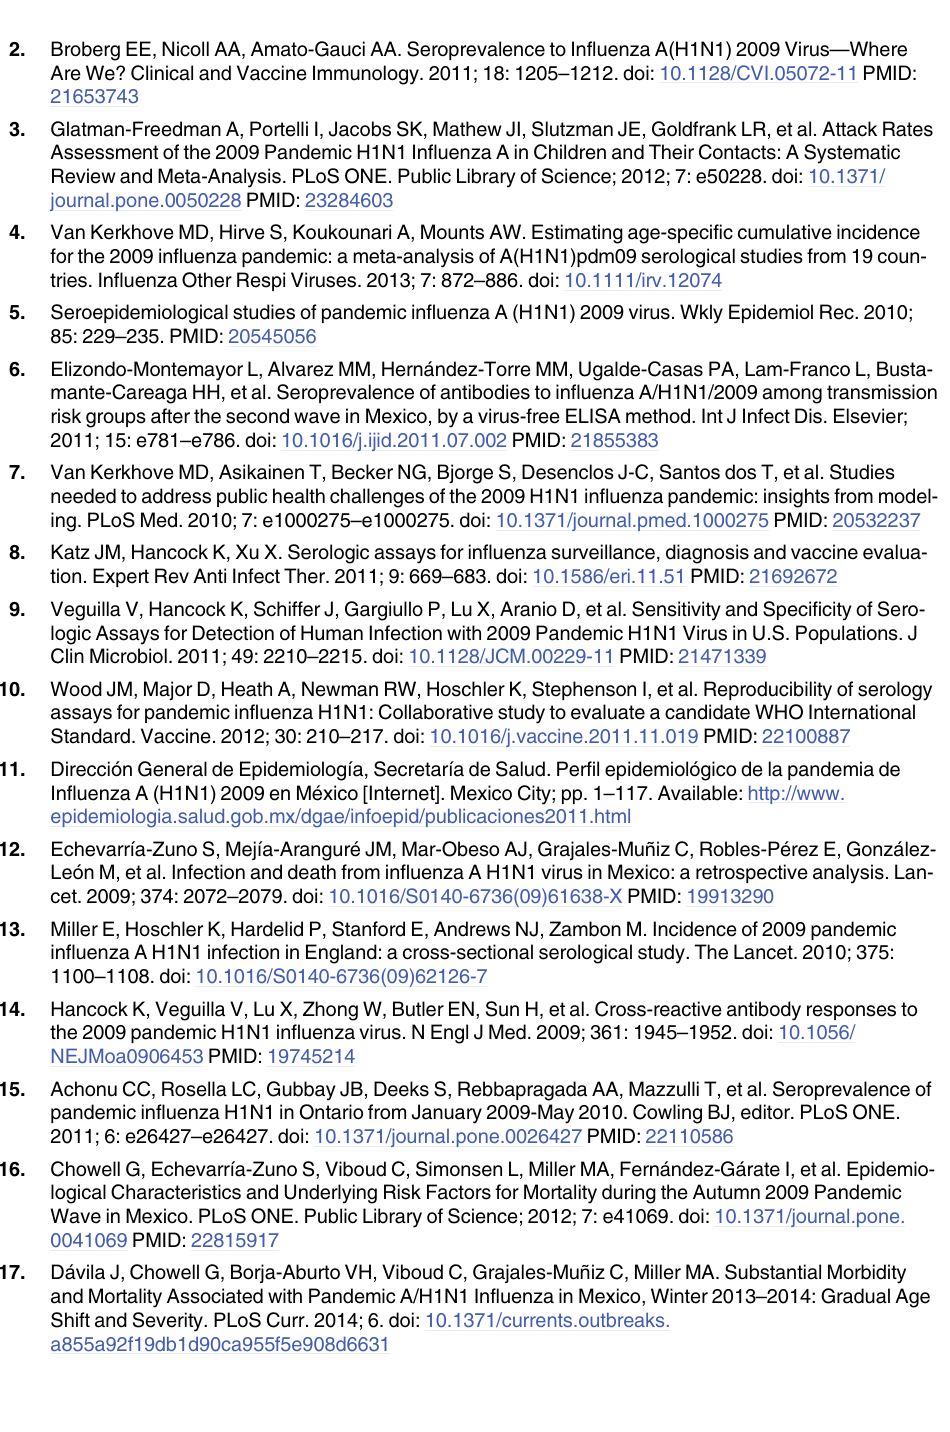
PLOS ONE | DOI:10.1371/journal.pone.0150428 March 22,